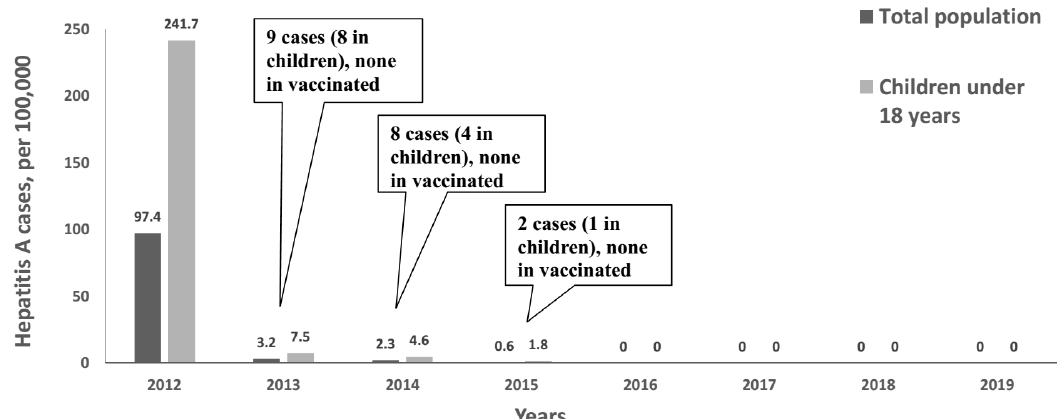
Figure 2. Hepatitis A incidence in both the total population and in children aged under 18 years in Tuva for the period 2012–2019. The callouts indicate the total number of hepatitis A cases registered each year.